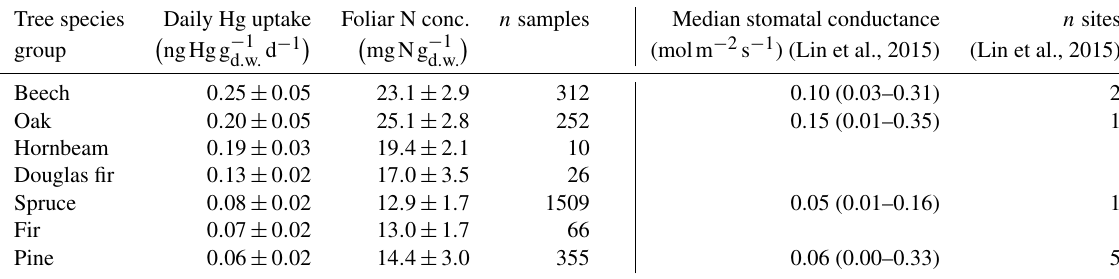
Table 1. Mean ± standard deviation of daily Hg uptake and foliar N concentration per tree species group from a subset of foliage samples harvested during July–August (broadleaf samples) or September–March (coniferous needle samples). Values are ordered from highest to lowest mean daily Hg uptake. All values from evergreen tree species groups (Douglas fir, fir, pine, spruce) were evaluated in current-season needles. Median stomatal conductance values (min–max) were calculated from a global database of leaf-level gas exchange parameters compiled by Lin et al.